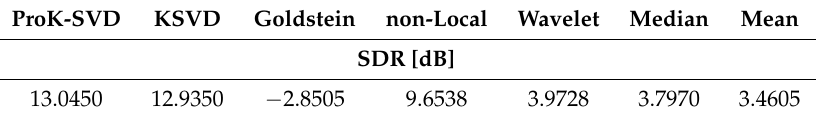
Table 3. Signal-to-Distortion Ratio (SDR) values relevant to ProK-SVD, K-SVD, Goldstein filter with parameter α = 0.5, non-local filter, wavelet filter, median filter, mean filter (ENVISAT SAR sensor